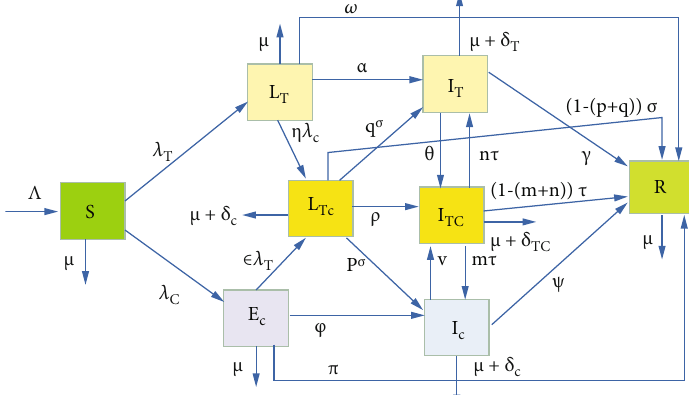
Figure 1: Flow diagram of the